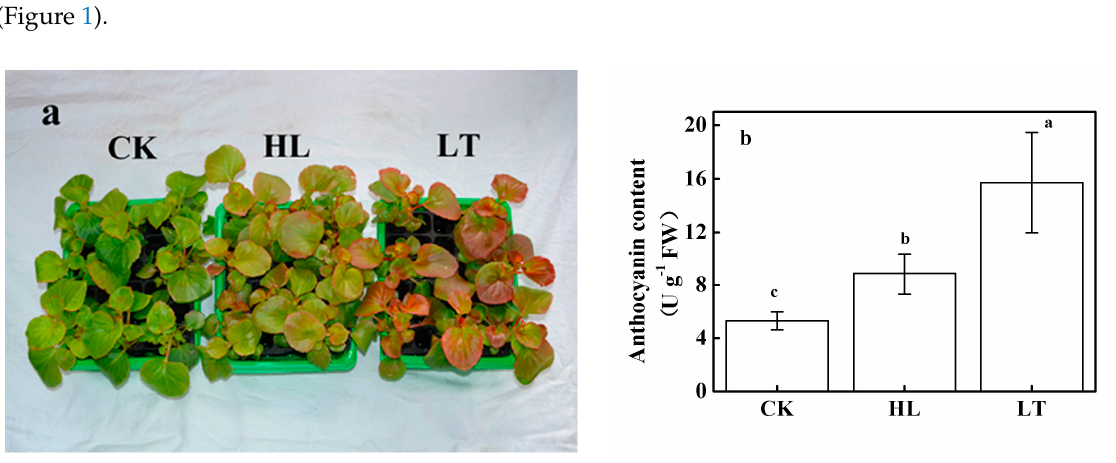
Table 1. Summary of the sequence assembly.